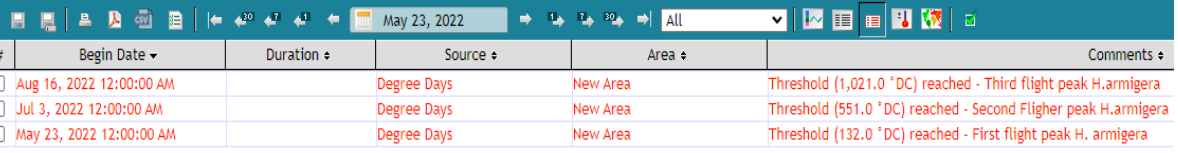
Figure 8. GUI event list output and the real time H. armigera thermal risk thresholds generated by Adcon® telemetry software plant protection decision support system used in the current study. Note that the default software output of 1,021.0 DC corresponds to 1021 accumulated DDs and so on.